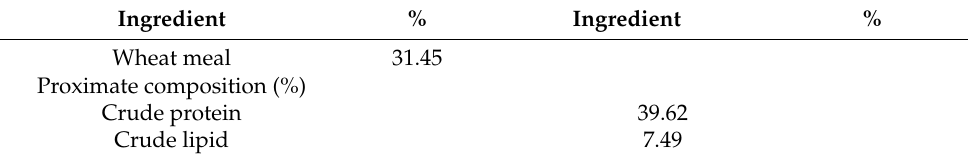
Table 1. Cont. Ingredient % Ingredient % Wheat meal 31.45 Proximate composition (%) Crude protein 39.62 Crude lipid